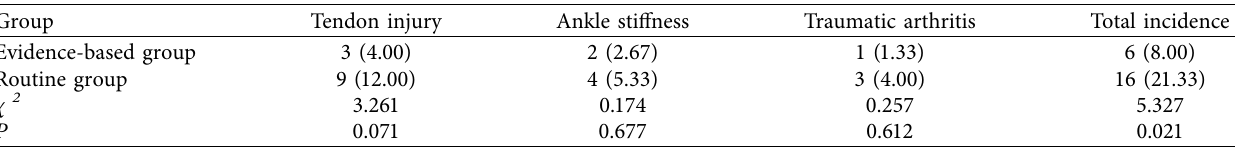
Table 3: Comparison of ankle joint function before and after intervention in the two groups ( n � 75, cases, %). Group Time First rate Well Evidence-based group Routine group Z after intervention P after intervention 0.002 Compared with the group of before intervention, a P < 0 . 05. Table 4: Comparison of the total incidence of complications between the two groups of patients during the intervention period ( n � 75, cases, %). Group Tendon